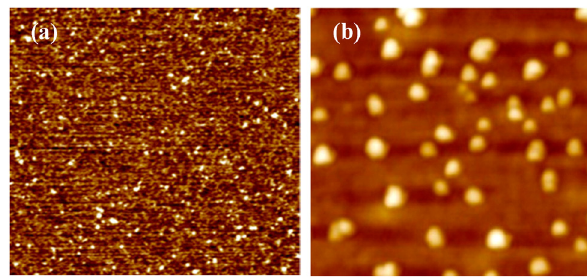
Figure 15: ( a ) AFM image of GQDs, ( b ) AFM image of CQDs. Adapted from ref. [ 83 ] and ref. [ 85 ] ,